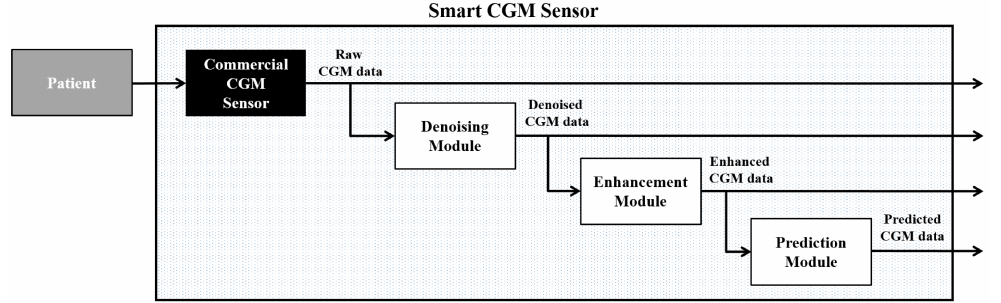
Figure 2. The smart CGM sensor architecture, which consists of placing, in cascade to the output of a commercial CGM sensor, three software modules, able to work in real time, for denoising the random noise component, enhancing the accuracy, and predicting the future glucose concentration (adapted from